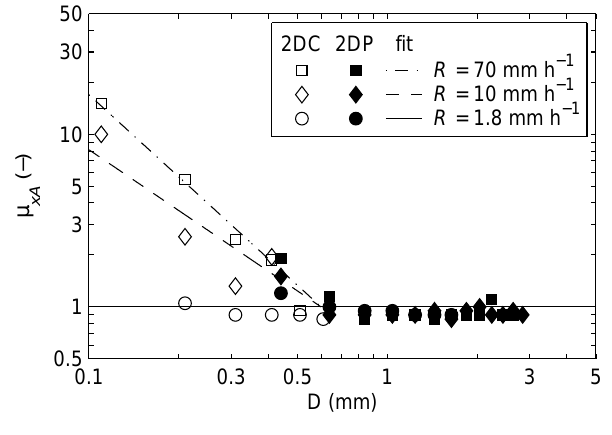
Fig. 2. Fits of relations between D and µ xA for different rainfall intensities to data from Fig. 2a of Montero-Mart´ınez et al. (2009), with 2-DC and 2-DP indicating the different instruments that were